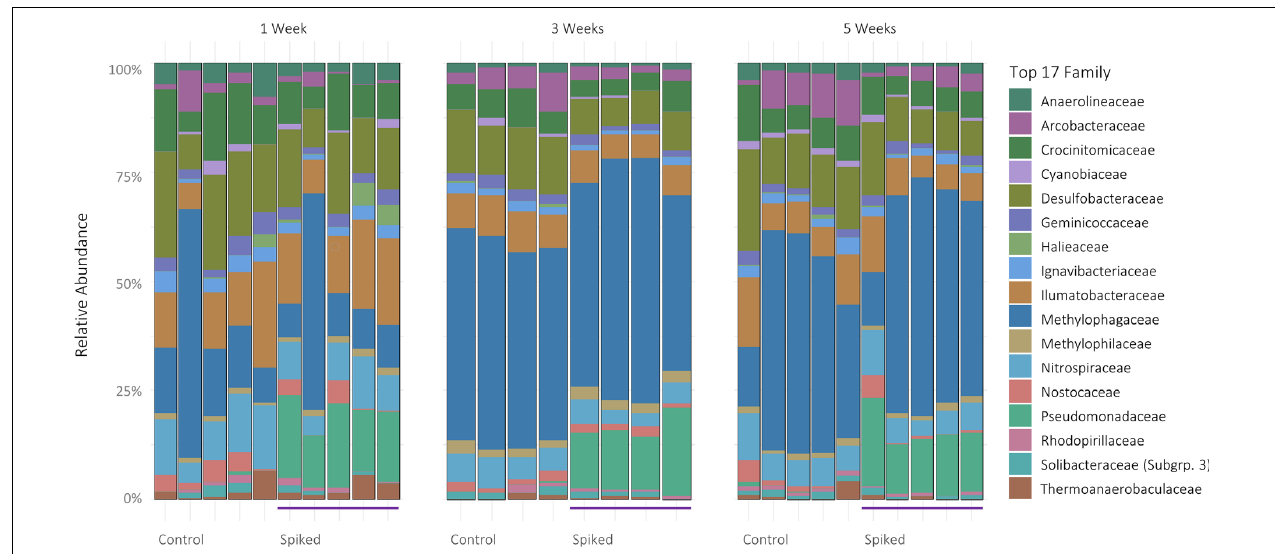
FIGURE 2 | 16S rRNA relative abundance of the top 17 most common prokaryotic Families, facetted by timepoint. Each bar represents a sampling replicate (5 replicates per treatment for week 1 and 5, 4 replicates for week 3).